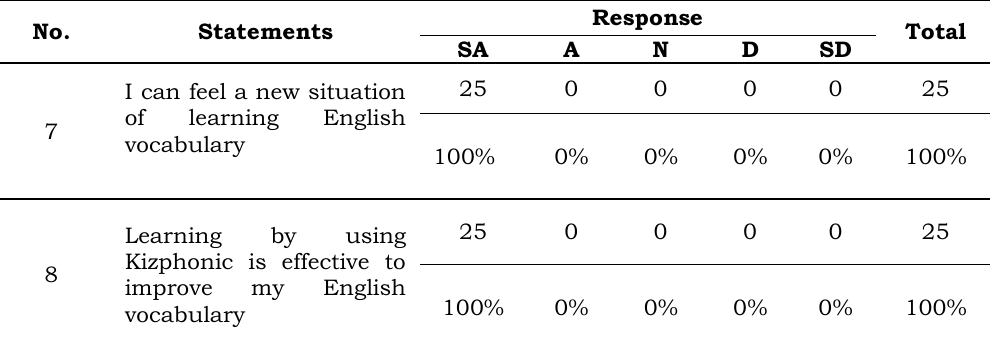
Table 9. Response to the questionnaire number